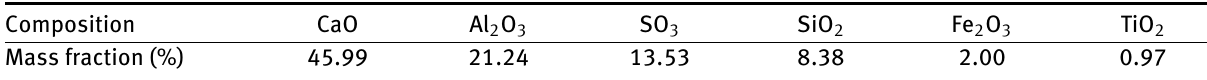
Table 1: Chemical composition of SAC Composition CaO Al 2 O 3 SO 3 SiO 2 Fe 2 O 3 Mass fraction (%)